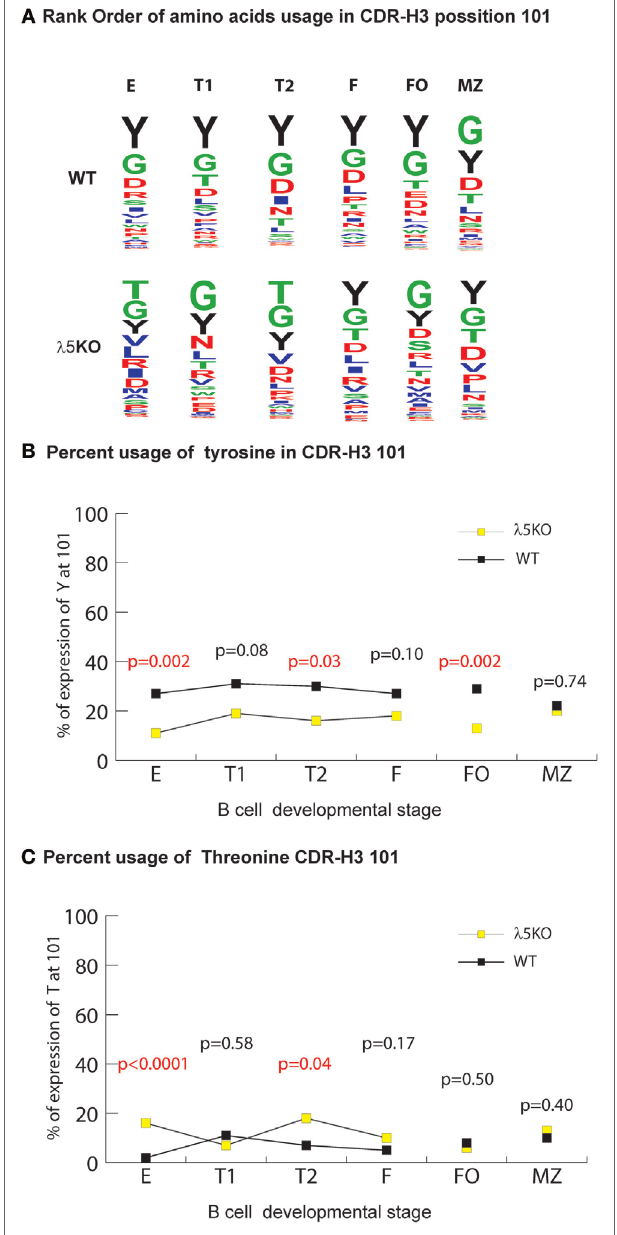
FigUre 5 | Selection for CDR-H3 Y101 in λ 5KO versus wild-type (WT). (a) The use of different amino acids in CDR-H3 position 101 in selected B cell subsets. Upper panel lists WT CDR-H3 amino acids at position 101 in rank order; the lower panel lists the homologous amino acids in λ 5KO mice, also in rank order. The size of the single letter is proportional to its prevalence. (B) Prevalence of Y101 and (c) T101 in selected B cell subsets. The p -values for the differences between λ 5KO and WT are shown. Those p -values that achieved statistical significance ( p ≤ 0.05) are marked in